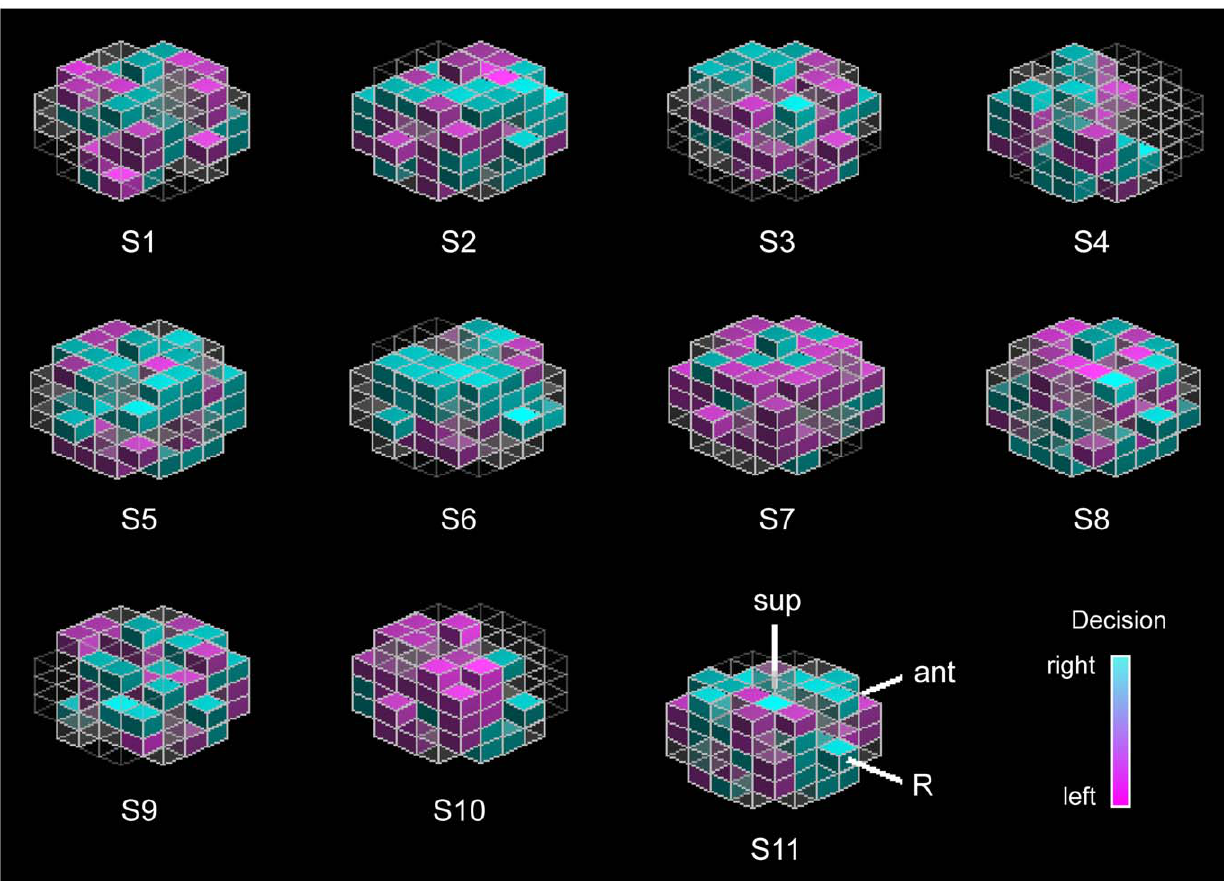
Figure 4. Individual searchlight clusters. Displayed are the spherical voxel clusters (with radius r=3 voxels) in frontopolar cortex of all subject that yielded the highest decoding accuracy in the time-bin directly preceding the decision ( 2 1.5 s). Voxels responding preferentially to one decision are colour-coded (magenta for left, aqua for right; sup=superior, ant=anterior, R=right). Grey transparent voxels did not show decision preference or were not located in grey matter. Colours are scaled for better visualization. Informative patterns were different for each participant.